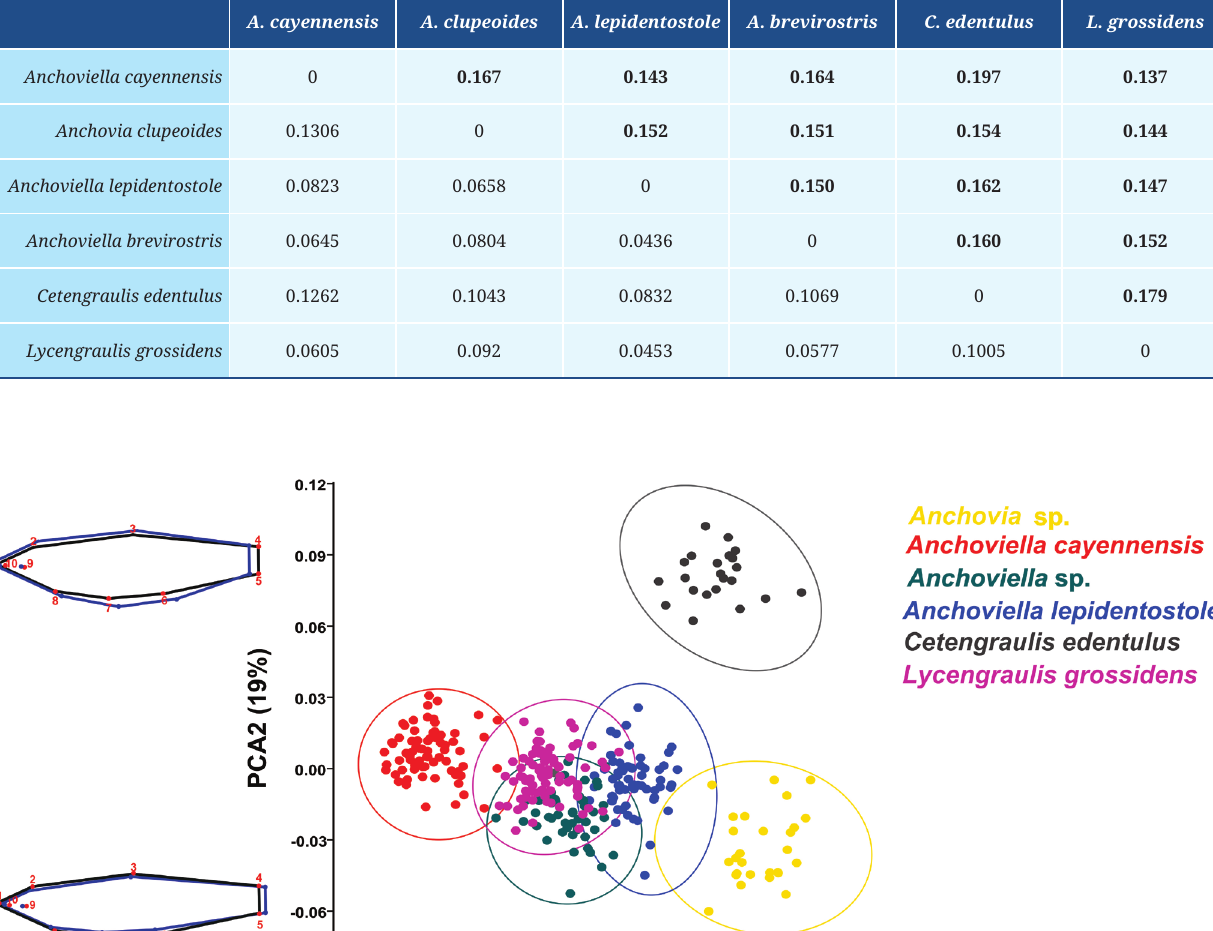
between L. grossidens and C. edentulus (17.9%) and the lowest distance between L. grossidens and A. cayennensis (13.7%) (Tab. 1). The molecular identification methods ‘Blastn and Species Level Barcode Records’ identified Anchoviella sp. and Anchovia sp., previously unidentified at the species level by traditional morphology as Anchoviella brevirostris (Günther, 1868) and Anchovia clupeoides (Swainson, 1839), respectively. The phylogenetic analyses (Fig. 6) resulted in a well-supported tree (bootstrap = 100,